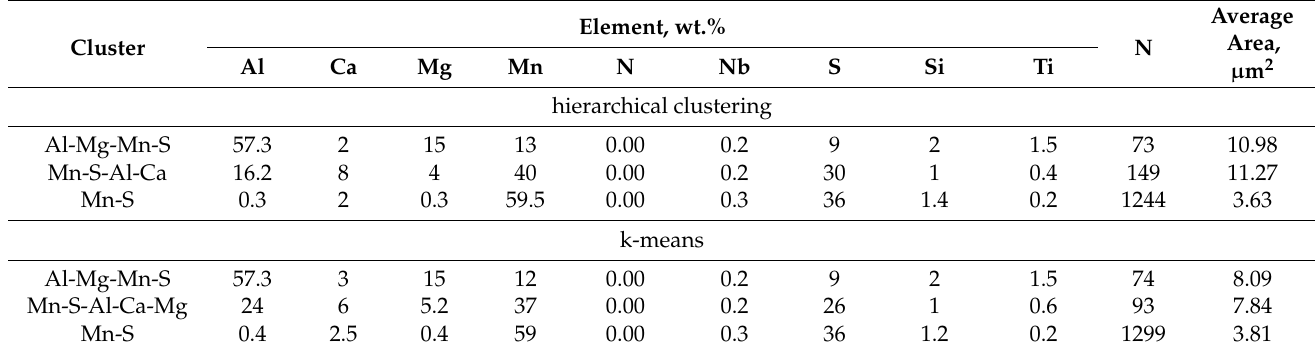
Table 3. Results of cluster analysis of the database in sample 1, steel 9MnSi5. Element, Cluster